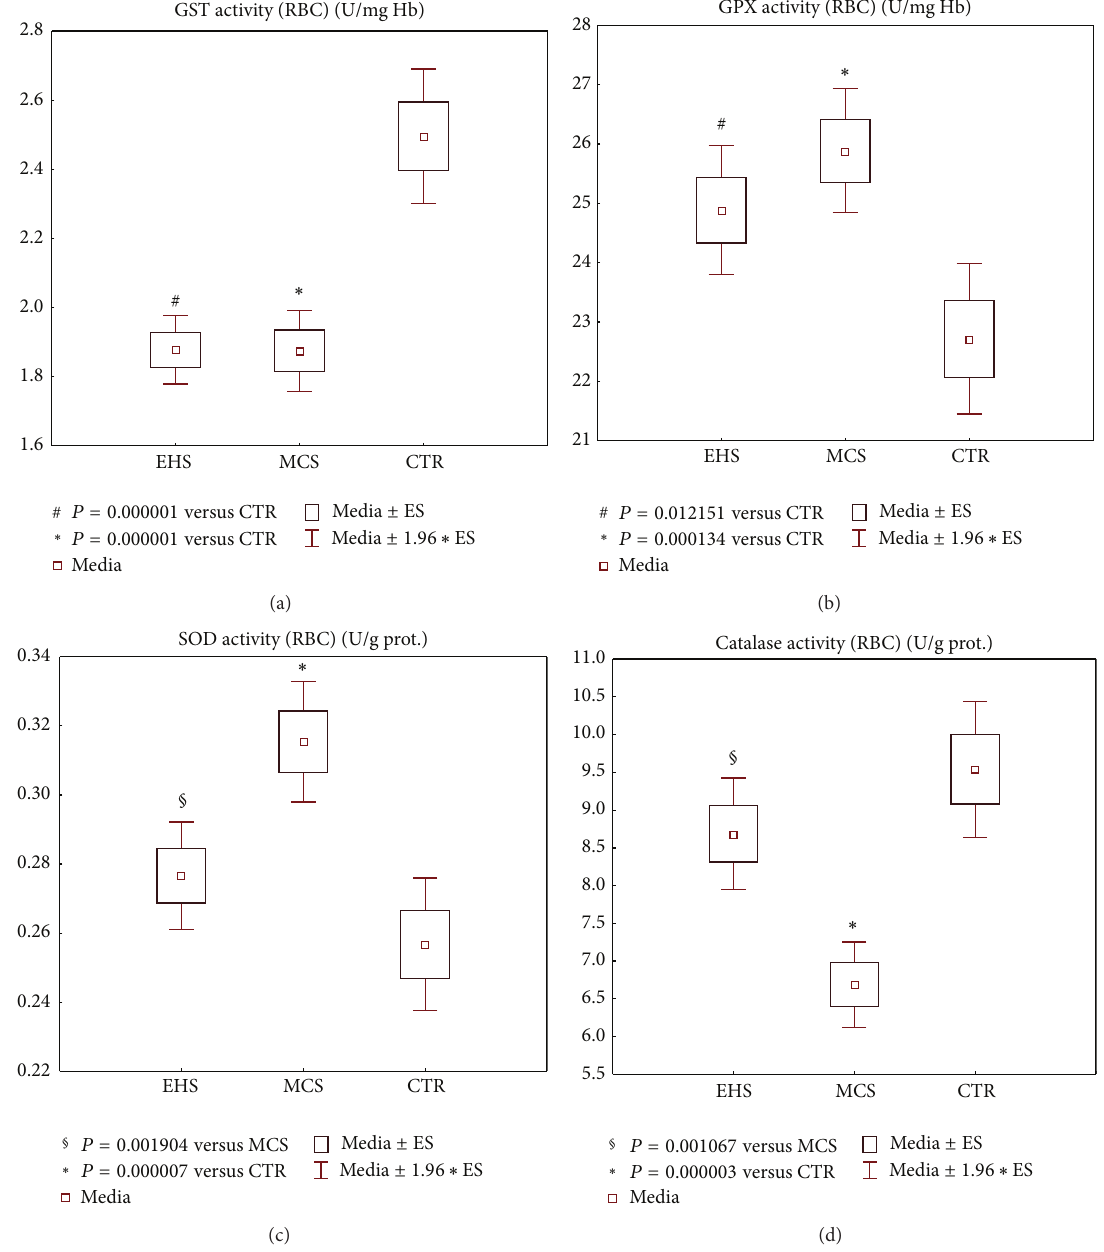
Figure 5: Metabolic redox parameters: the antioxidant/detoxification enzymatic activities of erythrocyte GST (a), GPX (b), CuZnSOD, (c) and catalase (d), in the groups of patients self-reporting electromagnetic hypersensitivity (EHS, 𝑛 = 153 ), of patients affected by multiple chemical sensitivity without EHS symptoms (MCS, 𝑛 = 147 ), and of control healthy subjects (CTR, 𝑛 = 132 ). Values are represented as mean ( ◻ ), standard error of the mean (upper and lower limits of the box), 1.96 × standard error (upper and lower whiskers). Intergroup significant differences ( P ) are reported under each panel. RBC: red blood cells; SOD (CuZn superoxide dismutase); GST: glutathione S-transferase; GPX: glutathione peroxidase; prot.: proteins; Hb: haemoglobin.